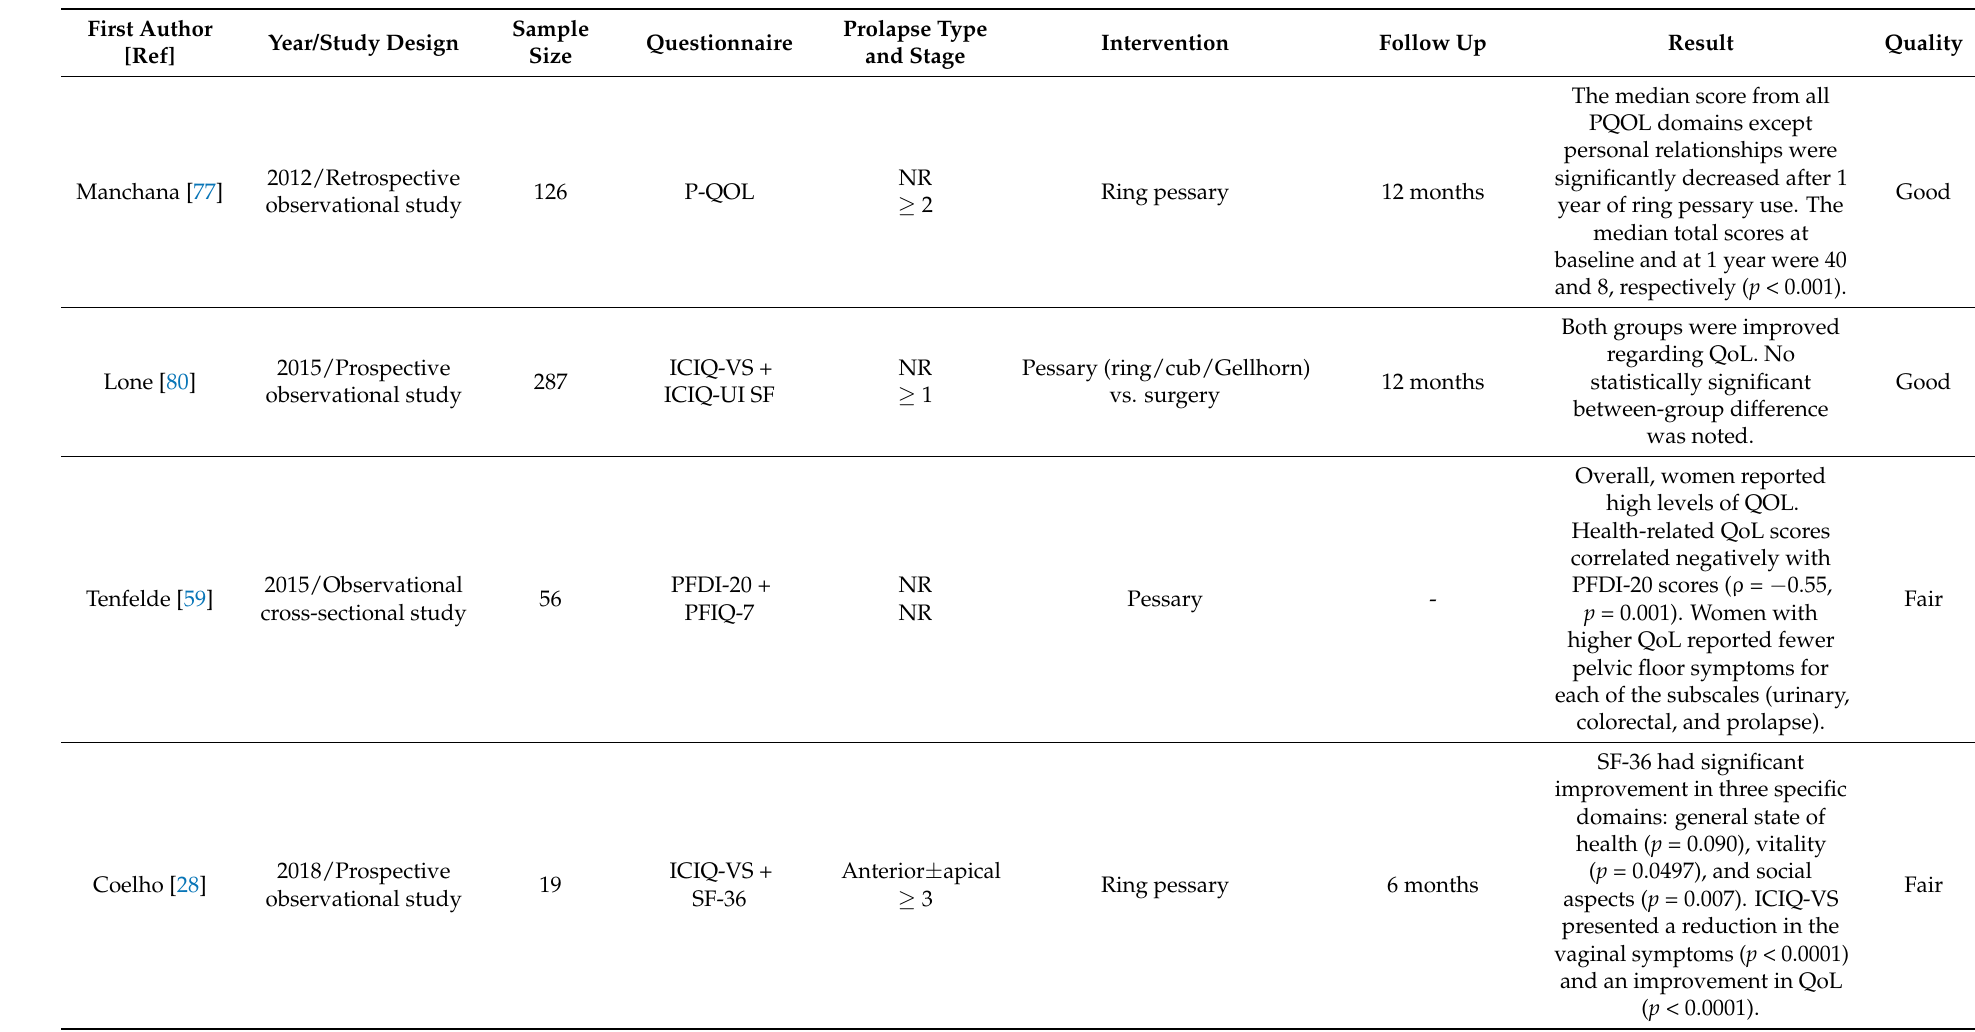
Table 6. The characteristics of the studies on the effectiveness of pessary on the quality of life in women with pelvic organ